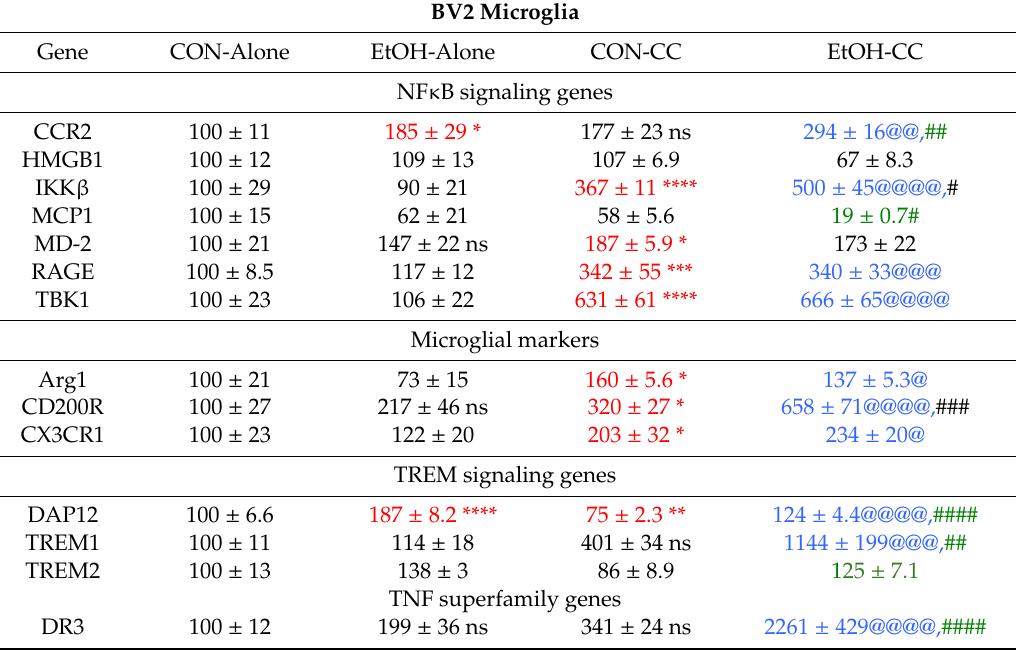
Table 2. Summary of e ff ects of ethanol and co-culture on gene expression in BV2